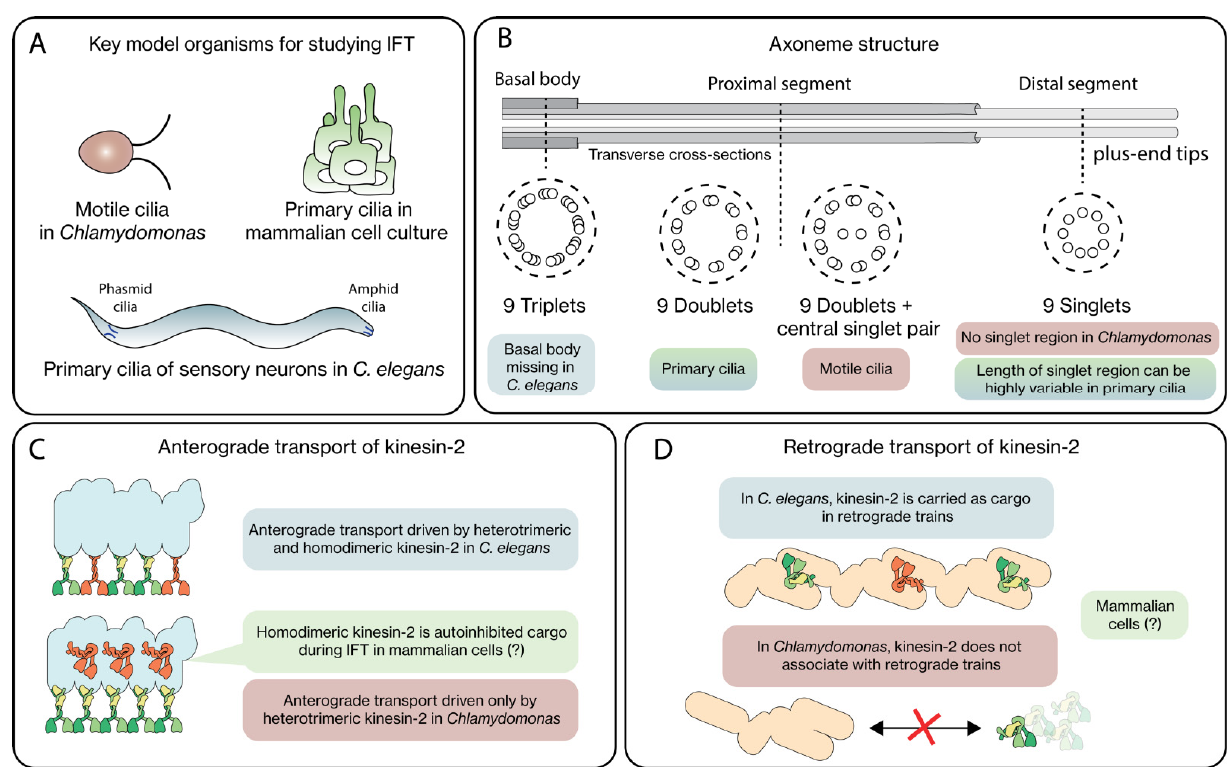
Figure 2. Differences in ciliary structure and IFT in key model organisms. ( A ) The motile cilia in Chlamydomonas , primary cilia of sensory neurons in C. elegans and the primary cilia of cultured mammalian cells are the most studied model organisms to study IFT. ( B ) The axoneme structure consists of 9 symmetrically arranged MT doublets, with their plus ends pointing outwards from the base to the proximal segment. In primary cilia, singlet MTs emanate from the MT doublets to form the distal segment. ( C ) In C. elegans , anterograde IFT is driven by heterotrimeric and homodimeric kinesin-2 motors, in contrast to Chlamydomonas , where heterotrimeric kinesin-2 is the sole driver of anterograde motion. In mammalian cells, the role of homodimeric kinesin-2 is still unclear. ( D ) In C. elegans , kinesin-2 motors link with retrograde IFT trains to be transported back towards the base, in contrast to Chlamydomonas , where the motors diffuse back. It is still unknown what scenario mammalian cells use.